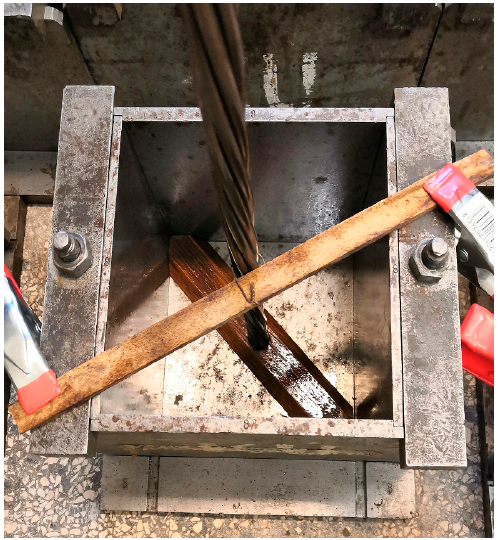
Figure 4. Anchoring of prestressing reinforcement in the axis of the cube according to the standard [26].